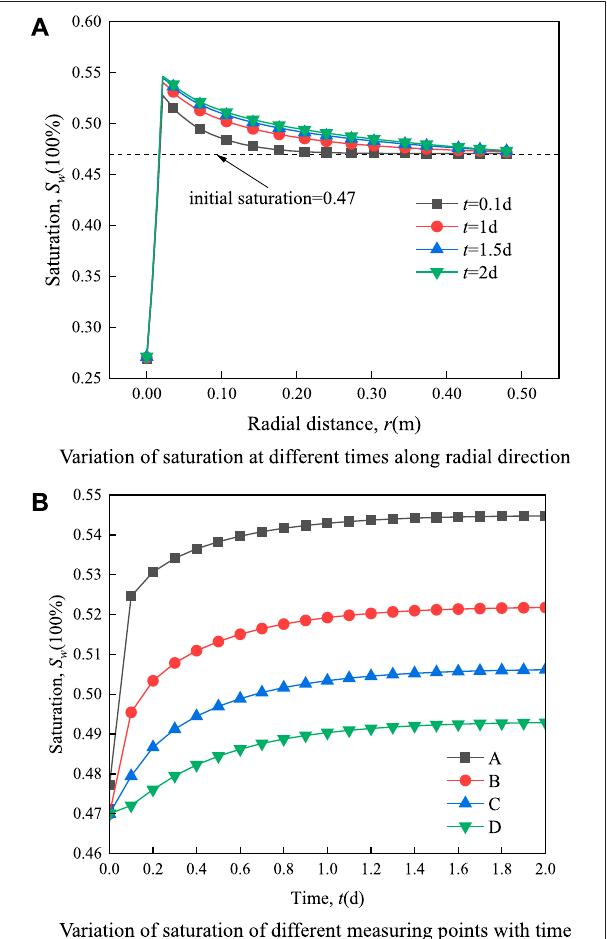
FIGURE 10 | Variation of saturation at height z = 0.25 m.